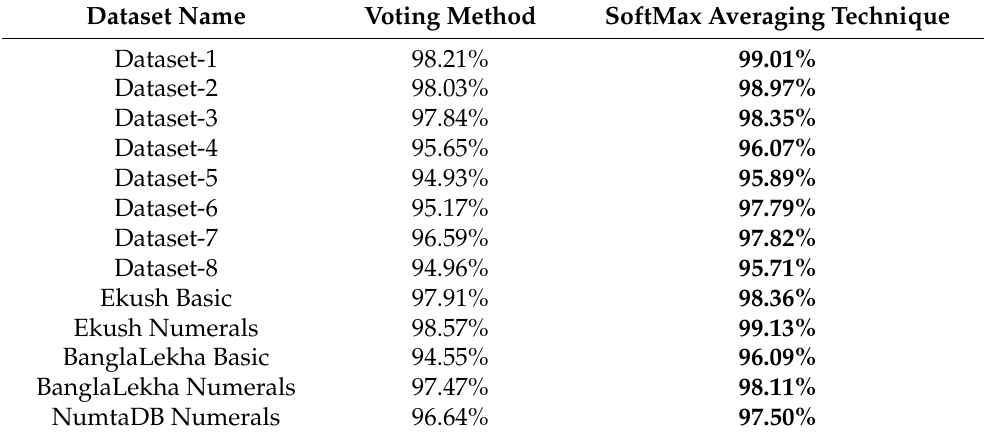
Table 10. Comparison of performance among SoftMax averaging technique and voting method for the considered